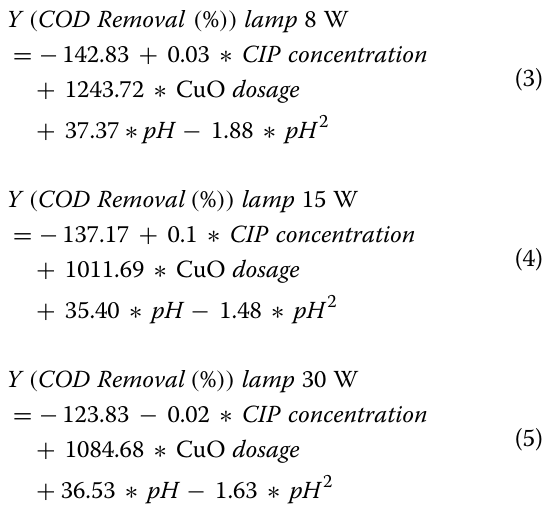
standard deviation (n ±